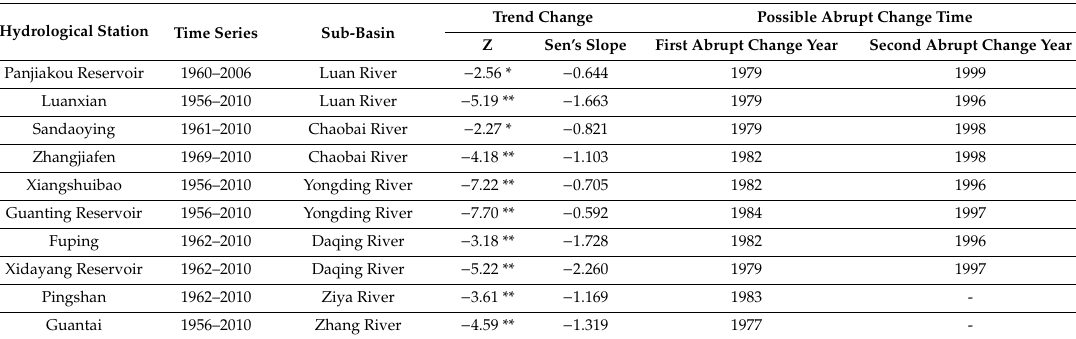
Table 2. Trend changes in annual runo ff and detection results of abrupt change in runo ff in the six sub-basins of the Haihe River Basin.